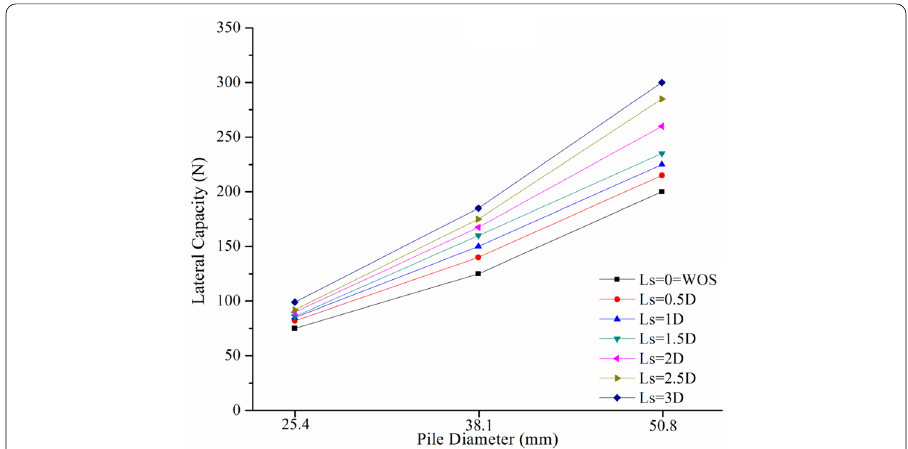
Fig. 8 Lateral capacity of pile with varying depth of socketing for pile having embedded depth L e 1000